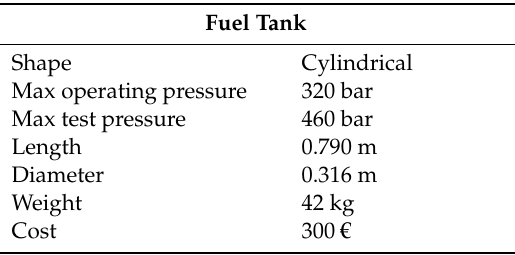
Table 13. Fuel tank specifications.